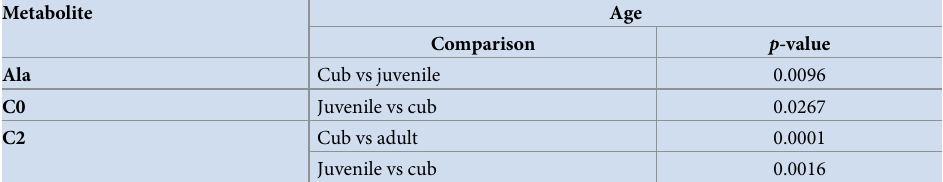
Table 2. Significant differences in amino acid and acylcarnitine reference values in blood samples of free-ranging U . americanus Pallas. Comparative analysis between different ages of bears. The column on the left gives the abbrevia- tions of the metabolites analyzed; comparisons between cub (1–2 years), juvenile (3–4 years) and adult (8 years) bears are shown. A significant difference was indicated by p <